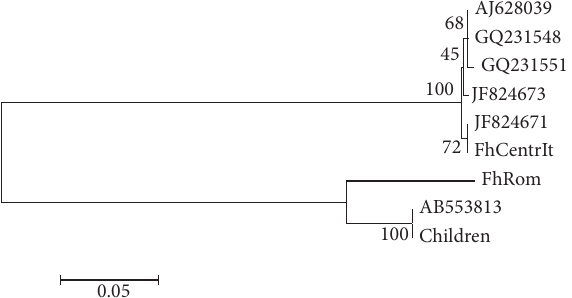
Figure 2: Dendrogram obtained by means of neighbour-joining analysis of COI sequences. Numbers at the nodes indicate percent- age of bootstrap support obtained in 1,000 replicates. The scale bar indicates the p-distance of the